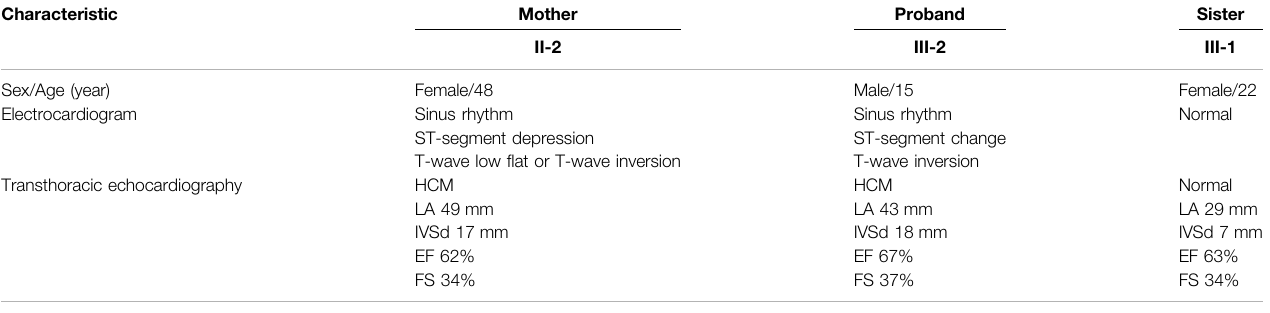
TABLE 1 | Clinical characteristics of individuals harboring the novel FLNC mutation. Characteristic